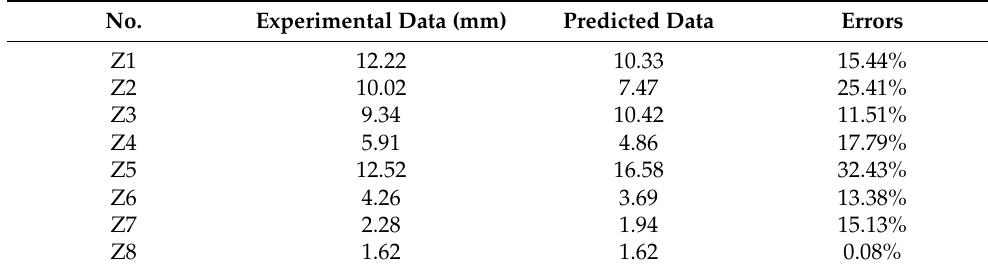
Table 10. Comparison of experimental data and predicted data for yield displacement.